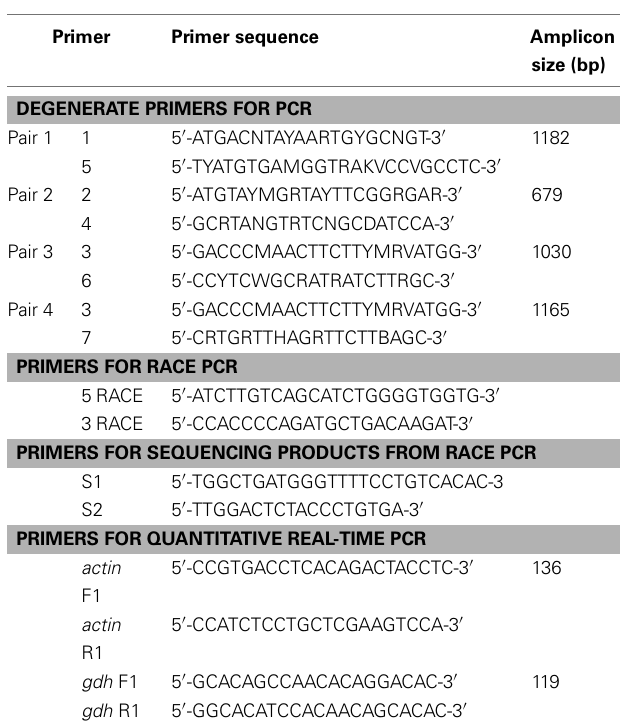
Table 1 | Primers for PCR or RACE PCR to amplify glutamate dehydrogenase ( gdh ), or for quantitative real-time PCR on actin (reference gene) and gdh1a from the liver, intestine, and brain of Monopterus albus